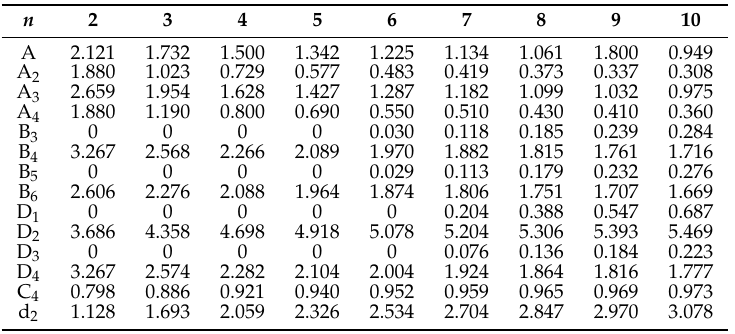
Table 5. Conversion coefficients for calculation of UCL, LCL in CC ( n = 10 in ISO